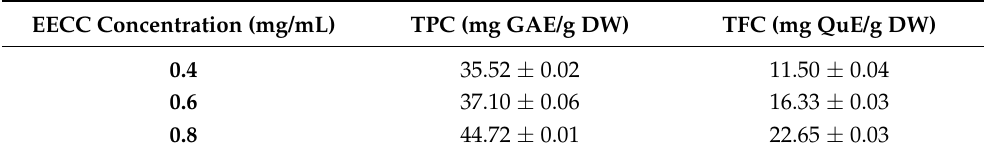
Table 1. Total phenolics and flavonoids content of ethanol extract of C. calcitrapa. Data represent mean ± SD of triplicates.